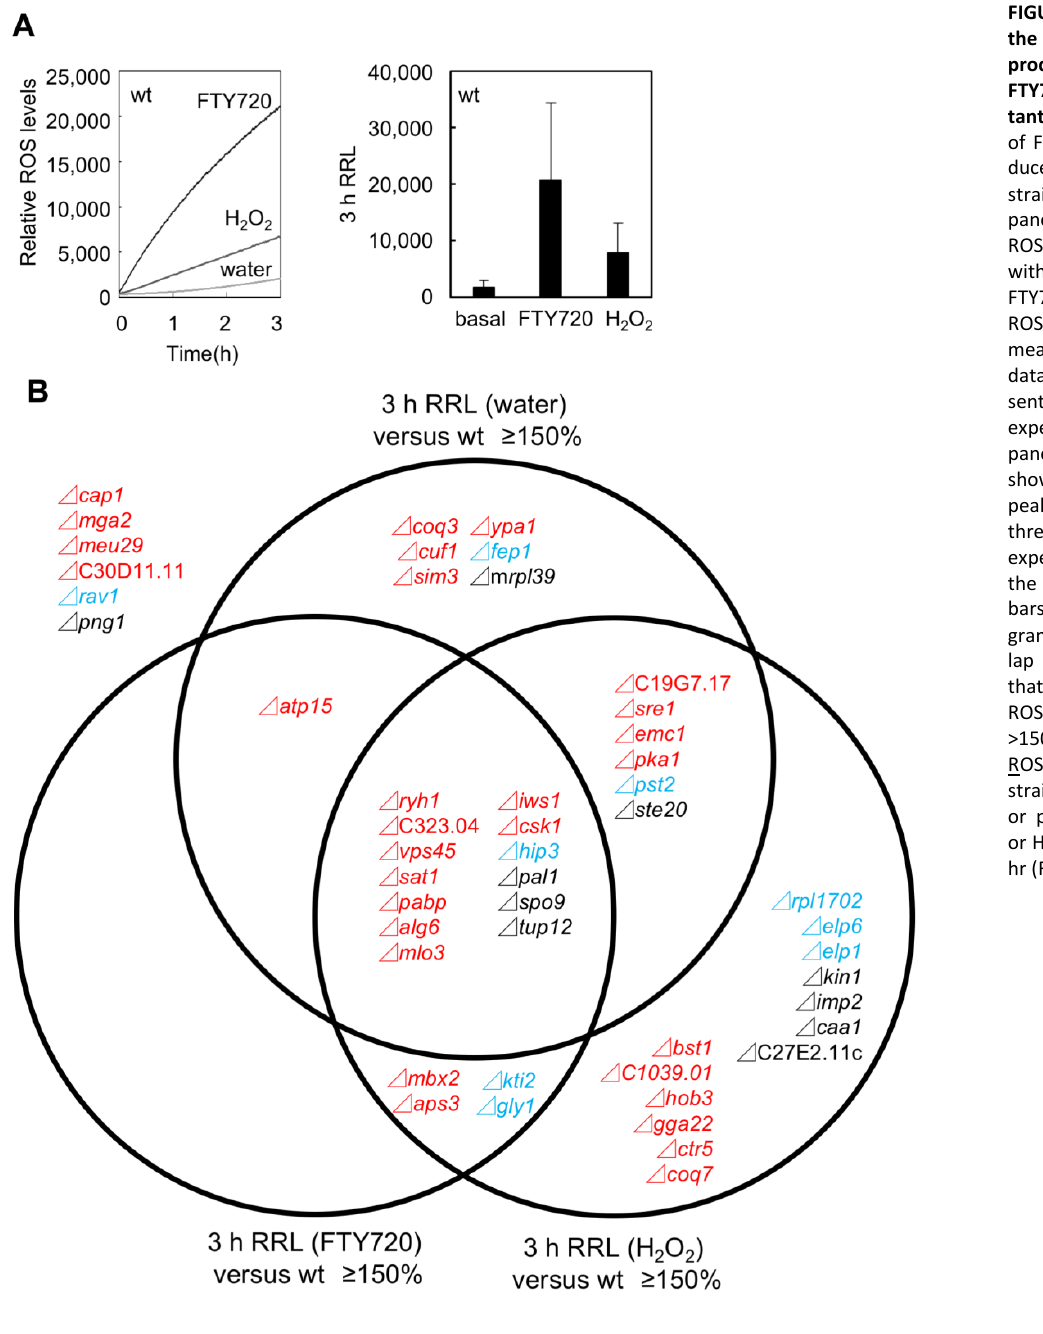
FIGURE 5: Summary of the difference of ROS production in these FTY720-sensitive mu- tants. (A) The addition